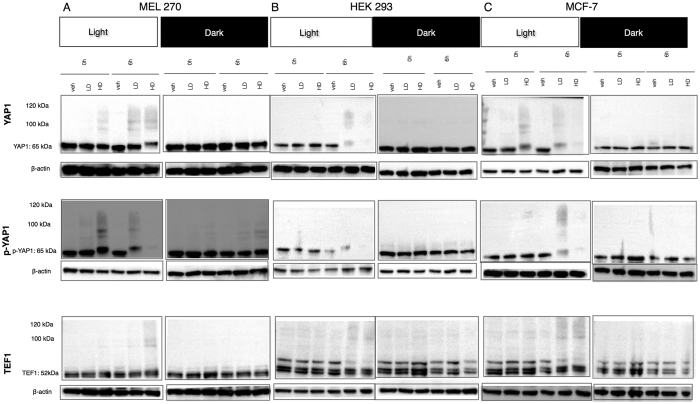
Light activated VP mediates down - regulation of YAP and phospho -YAP (p-YAP) protein expression in MEL 270(4A), HEK 293 (4B) and MCF-7 (4C) perhaps by the formation of HMWC.Western-blot of protein extracts from cells treated with vehicle (veh.), low dose (LD, 1.25 μg/ml) and high dose (HD, 7.5 μg/ml) of Verteporfin (VP) for 0 and 6 hours either in absolute darkness during all steps (treatment, lysis and electrophoresis) or in darkness only for the duration of treatment with subsequent steps of cell lysis and electrophoresis in ambient light. When all steps were performed in absolute darkness no difference in expression of YAP and p-YAP and there was no high molecular weight complexes. Notably there was no change in the expression of TEF1.